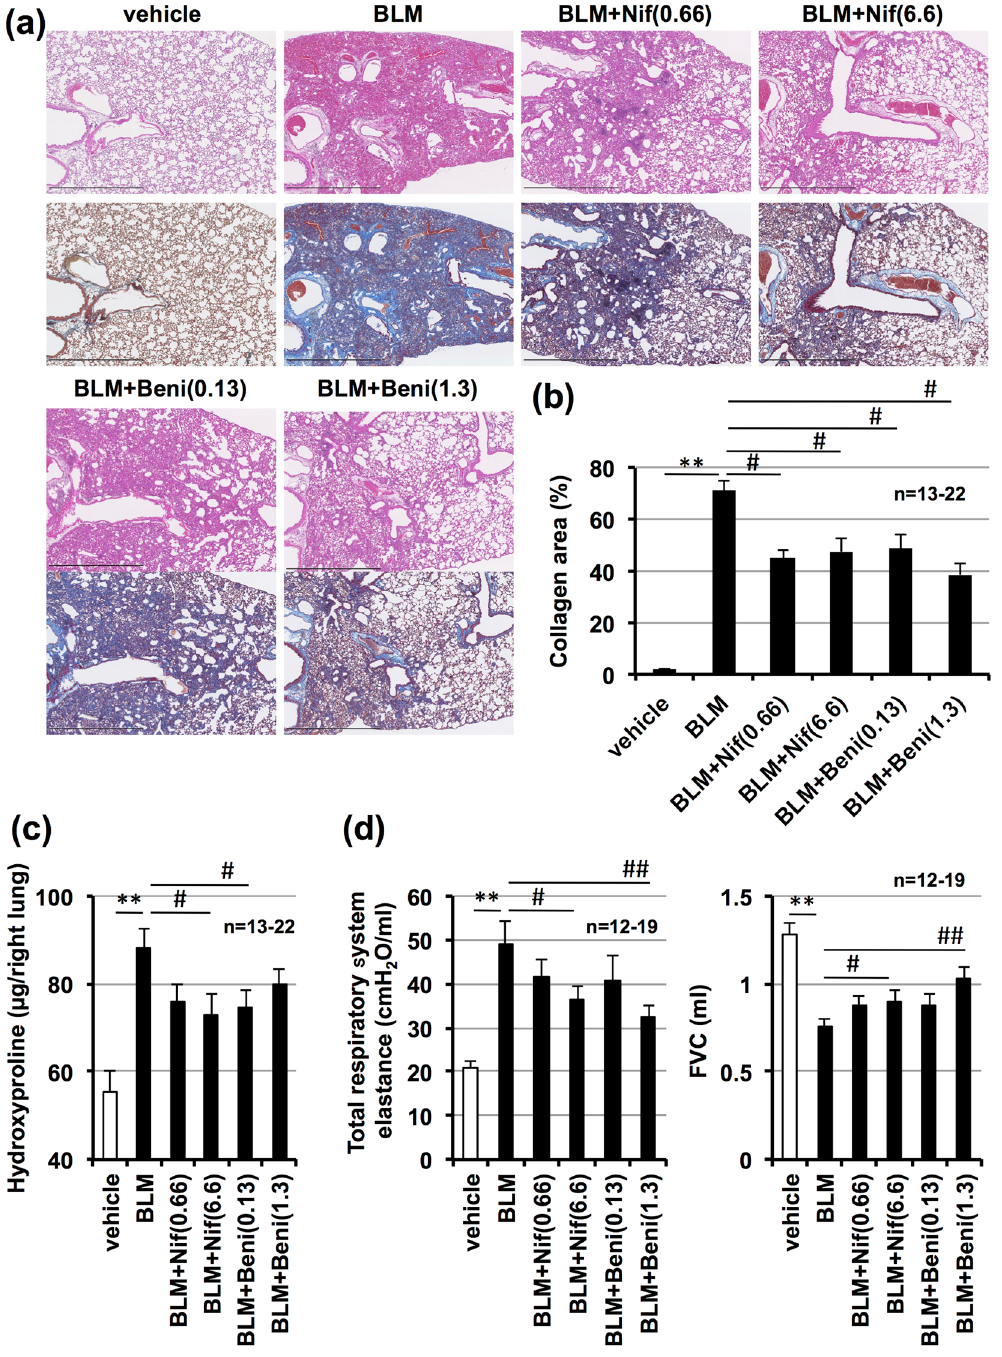
Figure 6. Effect of other calcium blockers on bleomycin-induced pulmonary fibrosis, alteration of lung mechanics, and respiratory dysfunction. Mice were intratracheally administered with bleomycin (BLM, 2 mg/kg) or vehicle once only on day 0. Mice were intratracheally administered indicated doses (mg/kg) of nifedipine (Nif) or benidipine (Beni) once daily for 14 days (from day 0–13). Sections of pulmonary tissue were prepared on day 14 (24 h after final calcium blockers administration) and subjected to histopathological examination. H&E staining (upper images) and Masson’s trichrome staining (lower images); scale bar = 1.0 mm ( a ). Percentage of collagen-positive area was determined based on images of Masson’s trichrome staining ( b ). Pulmonary hydroxyproline level was determined on day 14 ( c ). Total respiratory system elastance and FVC were measured on day 14 ( d ). Values represent mean ± S.E.M. * * or ## P < 0 . 01 and # P < 0 . 05 . ( * vs vehicle, # vs